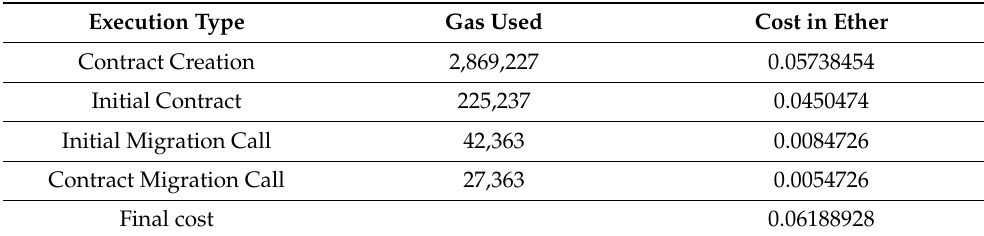
Table 2. Cost analysis of smart contract execution (gas cost = 2